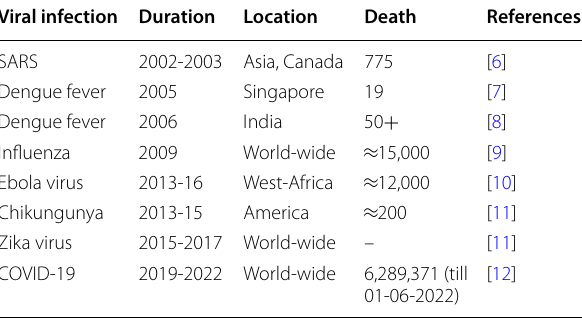
Table 2 Few major epidemic/pandemic of viral infections in 21 st century Viral infection